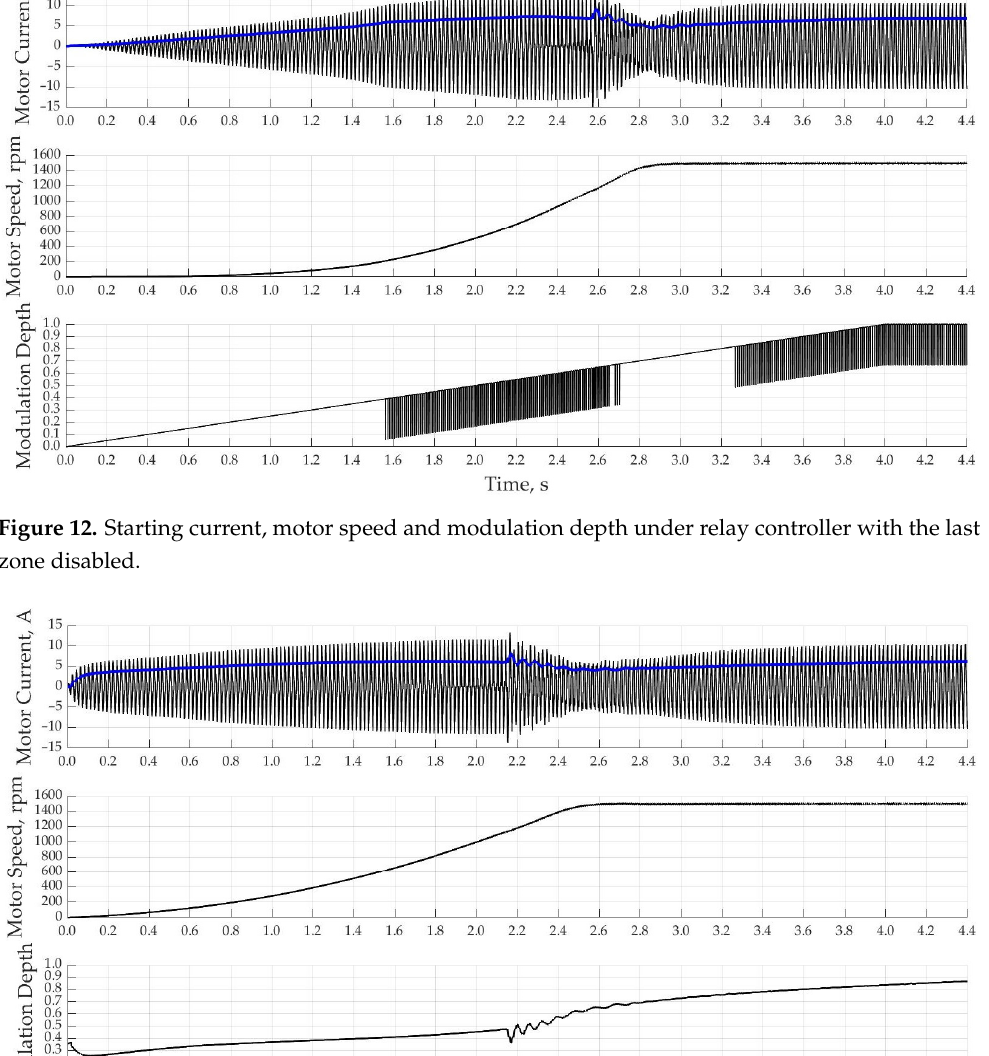
Figure 13. Starting current, motor speed and modulation depth under the PI-controller with single- loop CS of IM current with rated current according to reference.